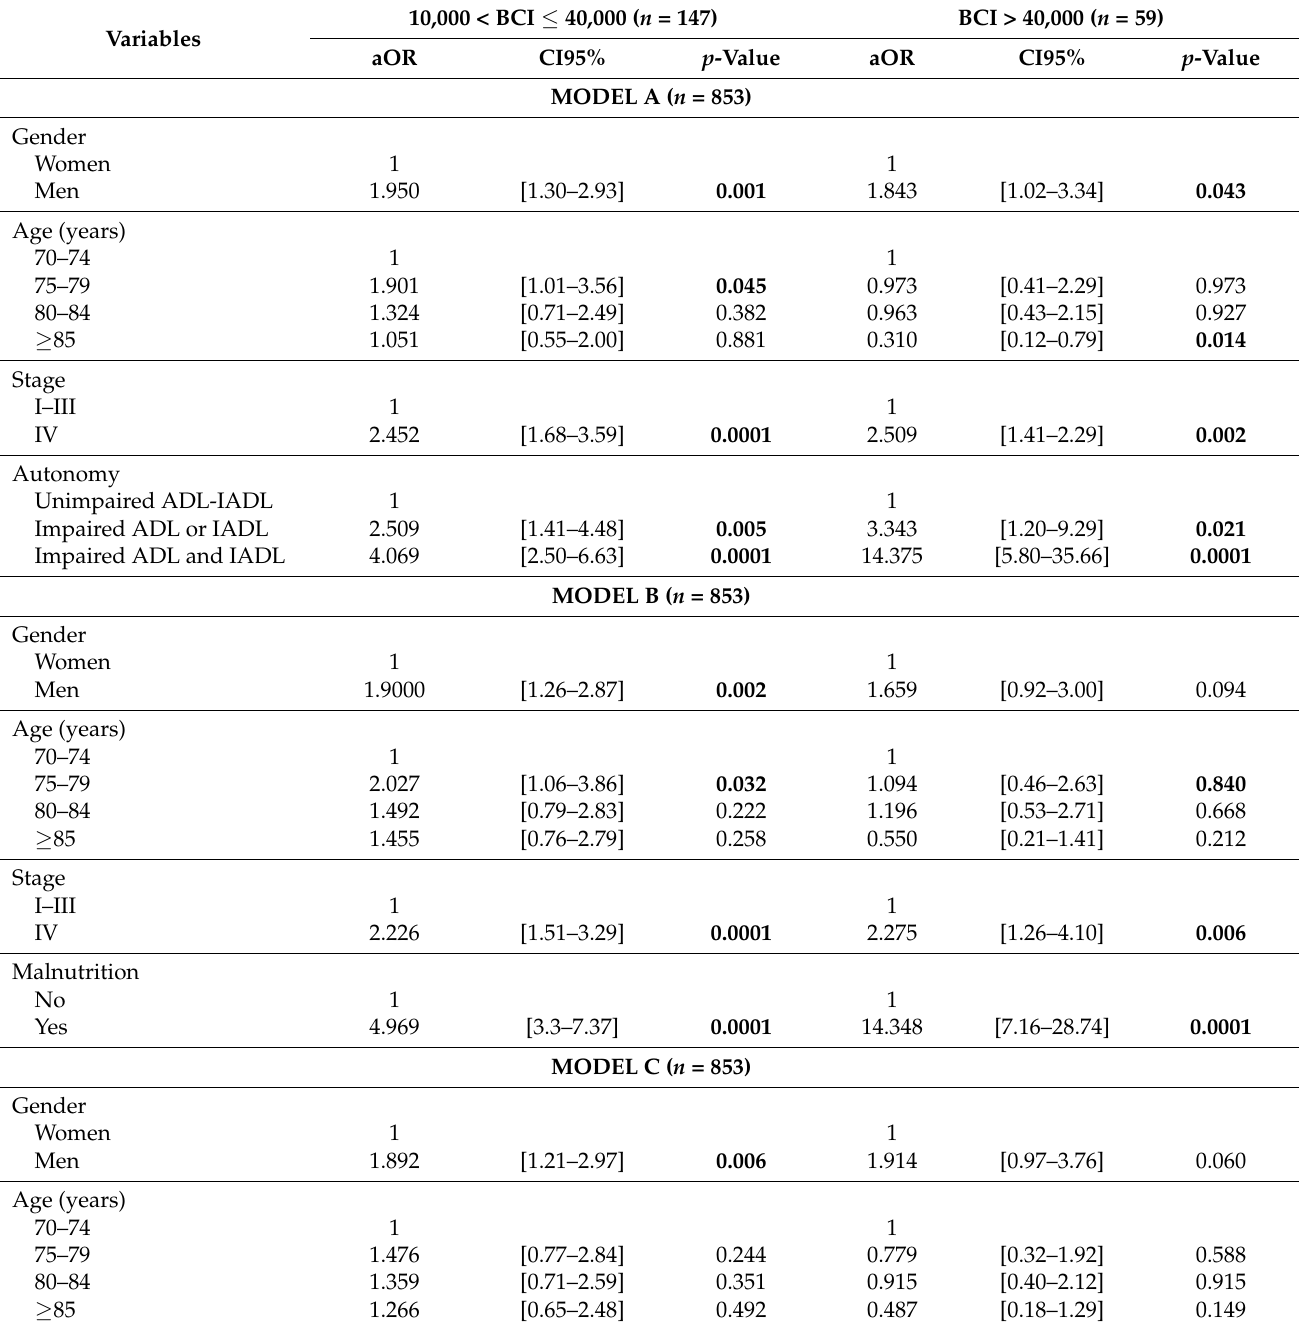
Table 2. Association between BCI level and geriatric characteristics (autonomy, nutrition, gait speed): multinomial logistic regression (Reference group is BCI <